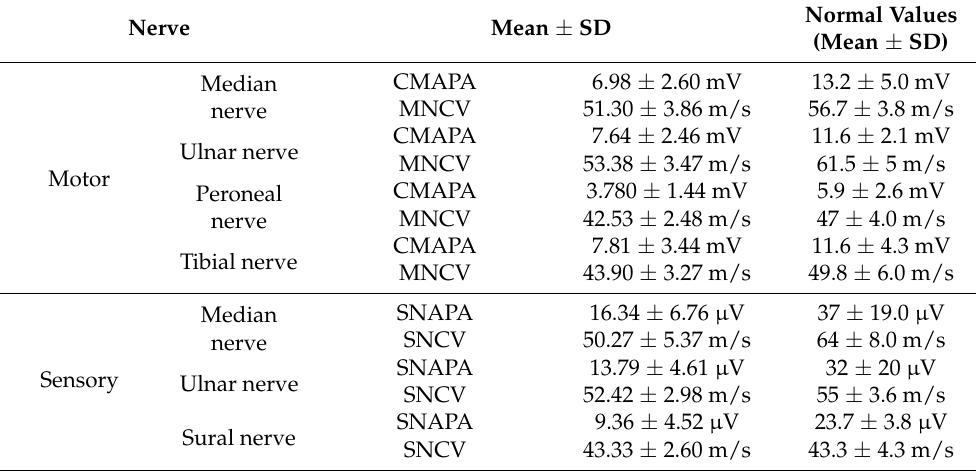
Table 2. Descriptive statistics of NCS values (mean ±